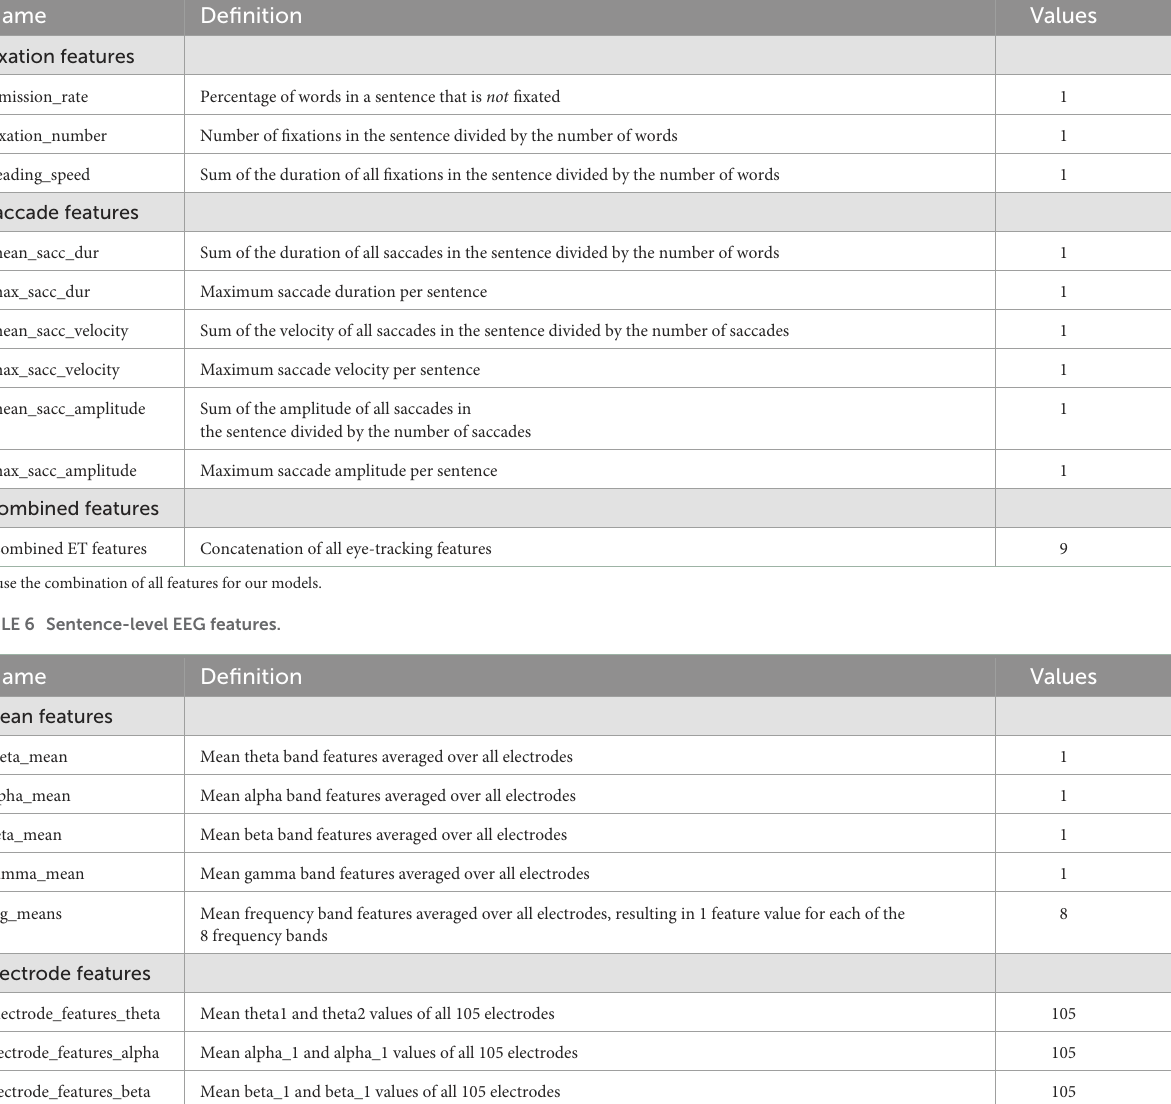
TABLE 5 Sentence-level eye-tracking features.